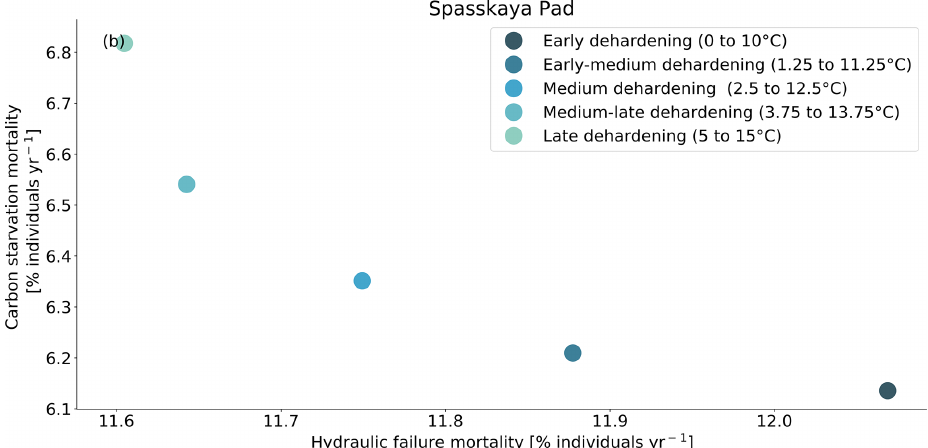
Figure 9. Trade-off between hydraulic failure mortality and carbon starvation mortality for evergreen needleleaf trees at Spasskaya Pad for five dehardening sensitivity experiments. The mortality rates are averaged over the 30-year period 1981 to 2011.